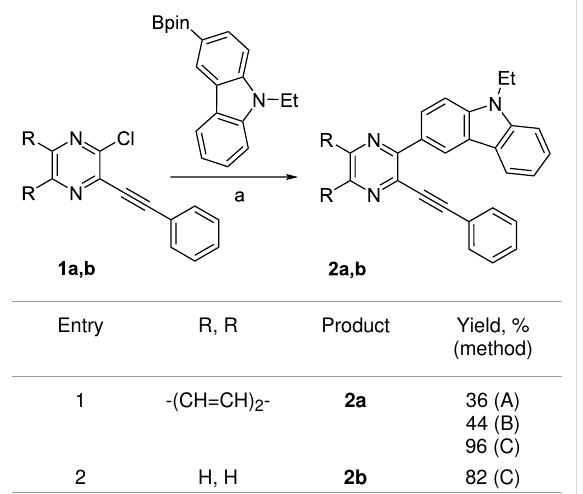
Table 1: Suzuki coupling of compounds 1a , b with 9-ethyl-3-(4,4,5,5- tetramethyl-1,3,2-dioxaborolan-2-yl)-9 H